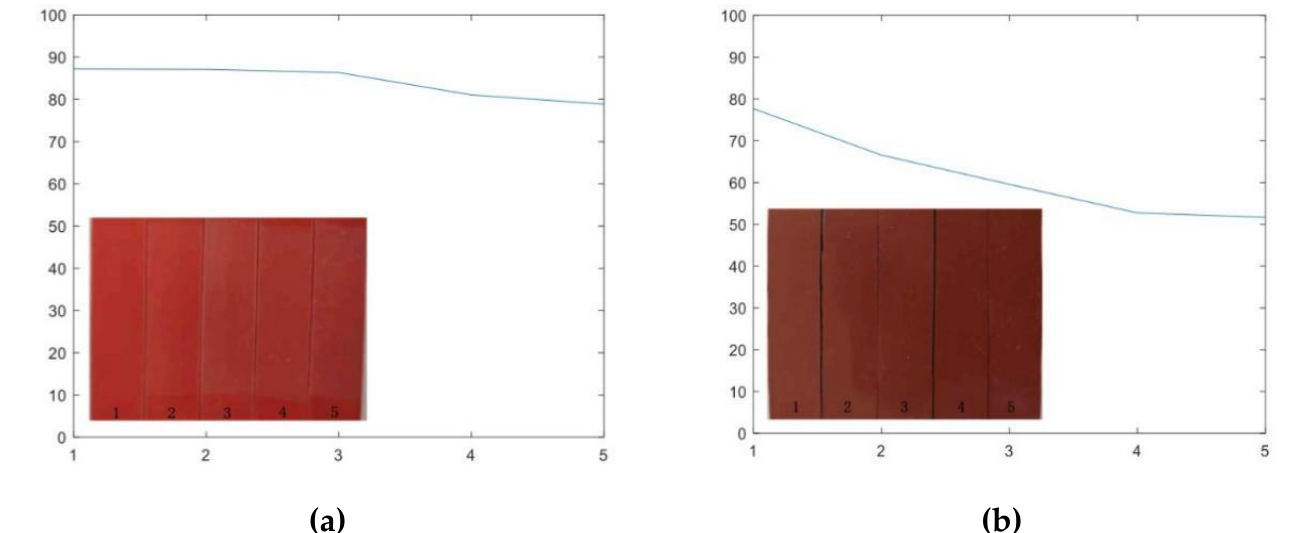
Figure 3. The appearance changes of two samples after different aging times: (a) The average gray level of the alicyclic epoxy resin sample; (b) the average gray level of the HTVSR sample.